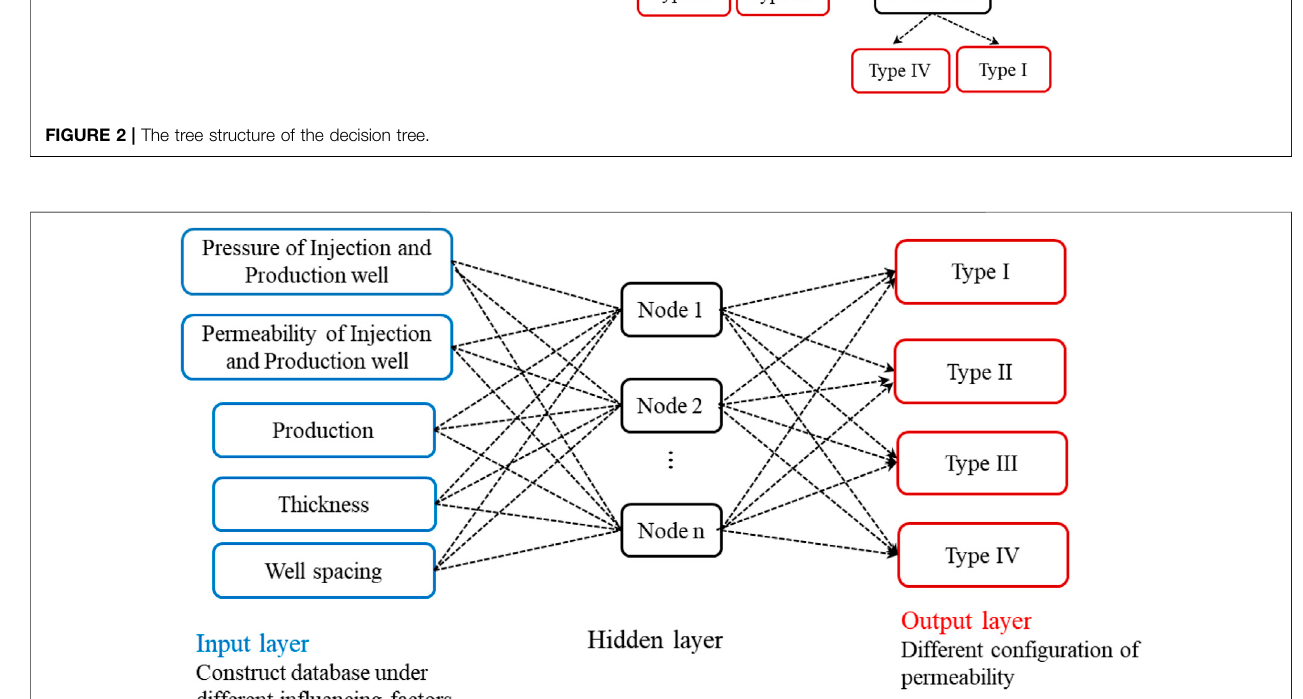
FIGURE 3 | The structure of the neural